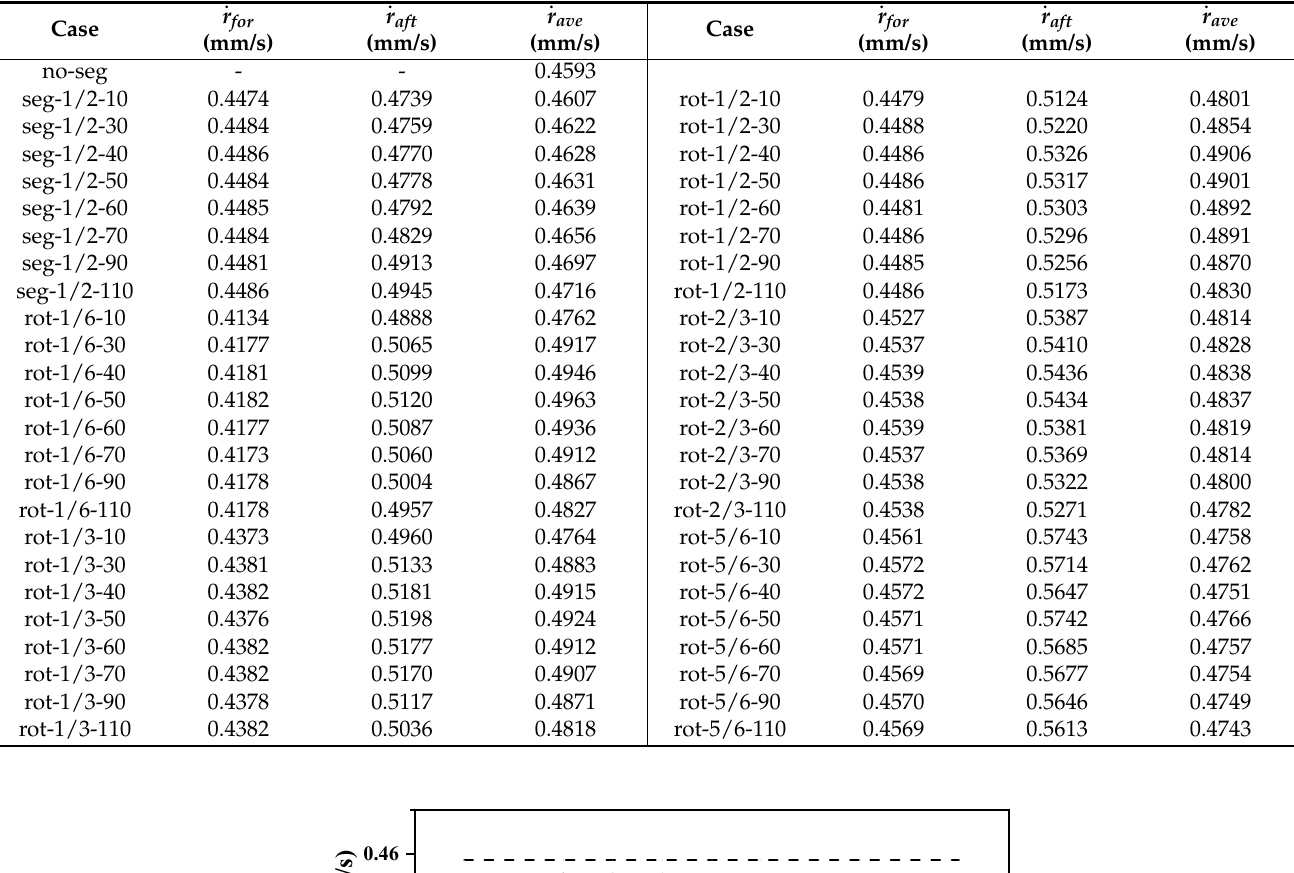
Table 5. Average area regression rates of the simulation cases.